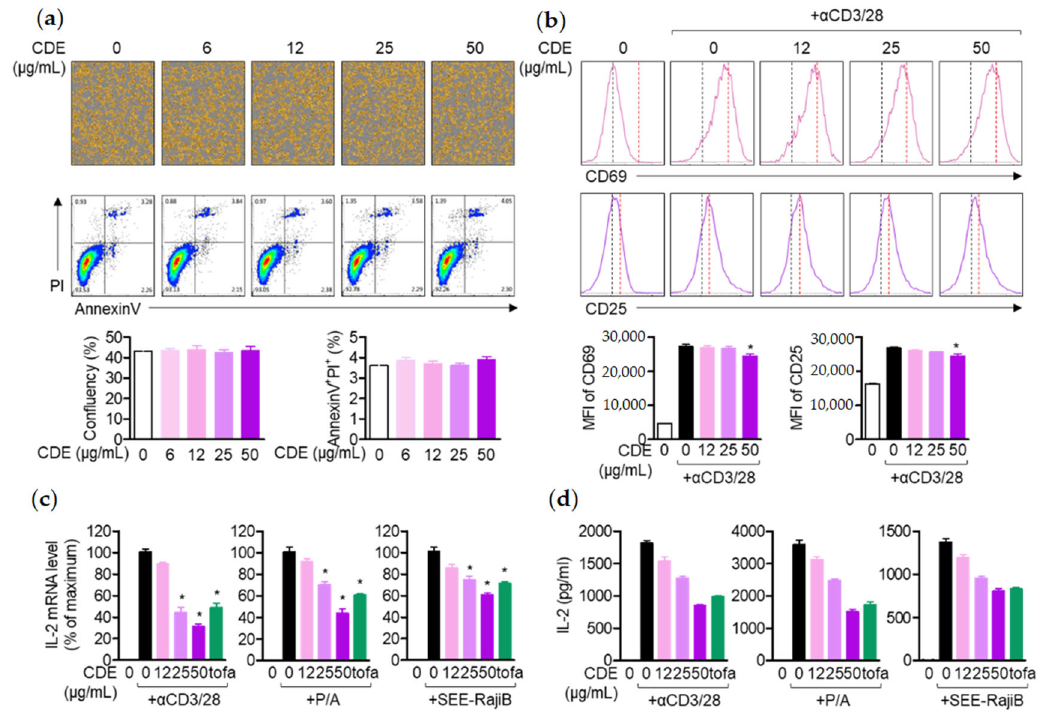
Figure 6. CDE inhibits the activity of T cells without cytotoxicity. ( a ) CDE did not show cytotoxicity; ( b ) Jurkat T cells were treated with CDE at the indicated concentrations for 1 h and then stimulated with anti-CD3 and CD28 antibodies for 6 h. Then, the harvested cells were dyed with anti-CD69 antibodies or APC connected with APC. The dyed cells were obtained by the cell analysis for fluorescence detection and the average fluorescent strength was obtained. The black dotted line shows the average fluorescence of the simulated cells, and the red dotted line indicates the average fluorescence of the anti-CD3/28 antibody. ( c , d ) In addition, Raji B cells (right) were loaded after stimulation with CD28 antibody, PMA (100 nM) and SEE (1 µ g/mL). The effect of IL-2 on mRNA levels was analyzed by real-time quantitative PCR, and released IL-2 was detected in each supernatant by ELISA. Results are expressed as mean ± SEM of three independent experiments (* p <